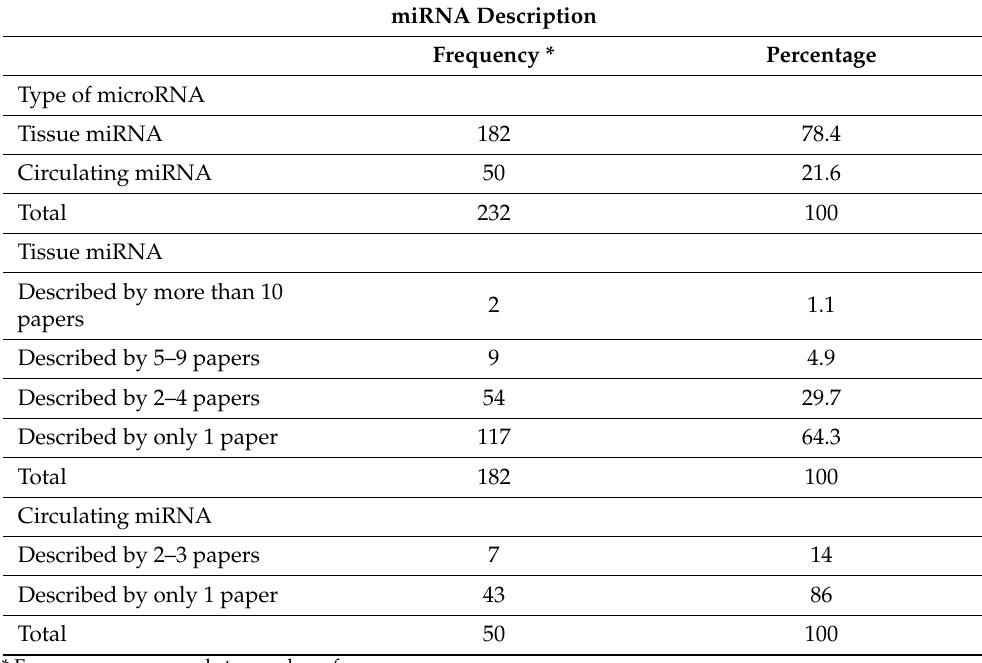
Table 2. Description of miRNA data of the 177 selected studies in this systematic